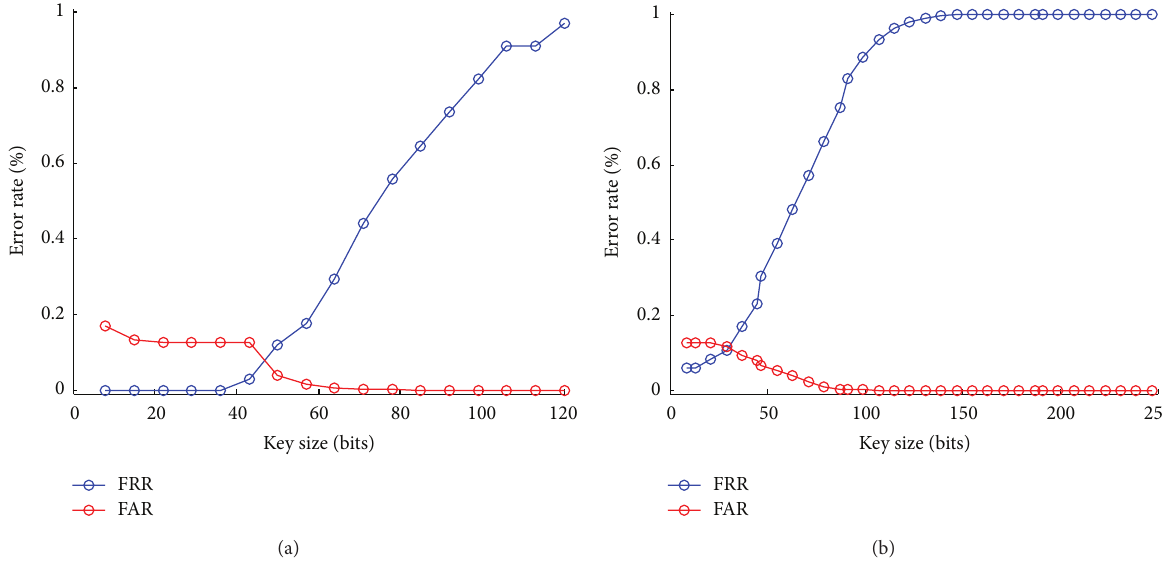
human gait captured from inertial sensors could be utilized to construct an effective BCS as other behavioral